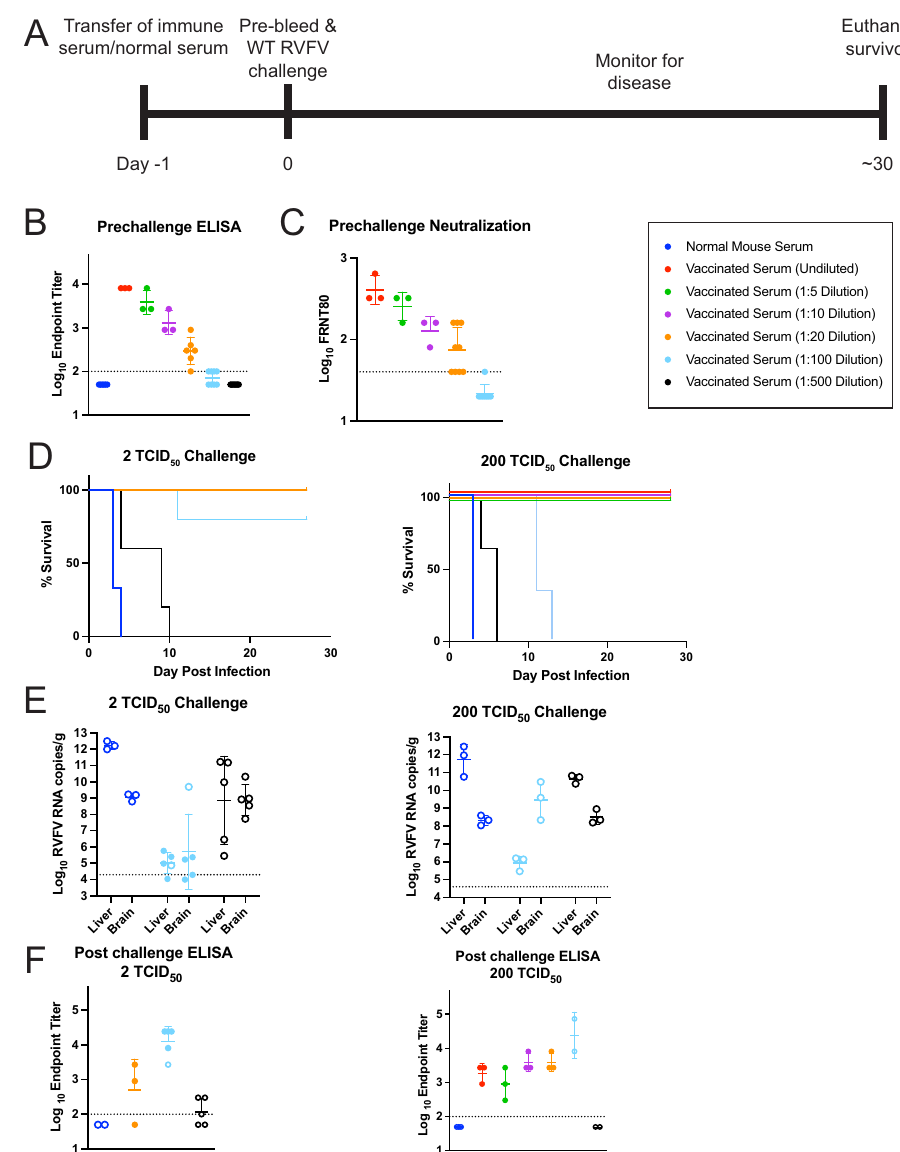
Fig. 3 Passive transfer of immune serum can protect from lethal RVFV. Naïve mice ( n = 3 – 5 per experimental group) were inoculated with 200 uL of serum from vaccinated mice, either undiluted or diluted 1:5, 1:10, 1:20, 1:100, or 1:500. Control mice were inoculated with normal mouse serum. All mice were bled then challenged with WT RVFV. A Endpoint titers of RVFV-speci fi c antibodies were determined via ELISA ( B ) and FRNT ( C ) 1 day prior to challenge. Mice were then challenged with 2 or 200 TCID 50 of WT RVFV and monitored for survival ( D ). Terminal viral RNA load ( E ) and ELISA titer ( F ) were also measured. Open circles in E&F represent animals that died or required euthanasia while closed circles represent animals that survived; the dotted line is the LOD of the assay. For ELISA and FRNT 80 graphs the dotted line is the LOD (100 for ELISA, 40 for FRNT 80 ). Negative values were plotted at 50 and 20, respectively. Geometric means and geometric standard deviation are highest in the brain in mice that succumbed in the second-week post-infection (Fig. 3E). Surviving mice ( fi lled circles) had viral RNA loads near the LOD of the assay. Post-challenge ELISA titers GMT of 89 or above was achieved. demonstrated that mice receiving undiluted immune serum or serum diluted 1:5 had decreased titers at the time of euthanasia; however, those receiving lower concentrations of serum (1:10, 1:20, and 1:100) showed increased antibody titers at the time of euthanasia, suggesting a de novo immune response to challenge in mice receiving lower doses of antibodies (Fig. 3F). Notably, in the mice receiving immune serum diluted 1:100 and challenged with 200 TCID 50 of WT RVFV, neither the low level of administered antibodies nor the de novo immune response was able to provide protection from RVFV encephalitis.